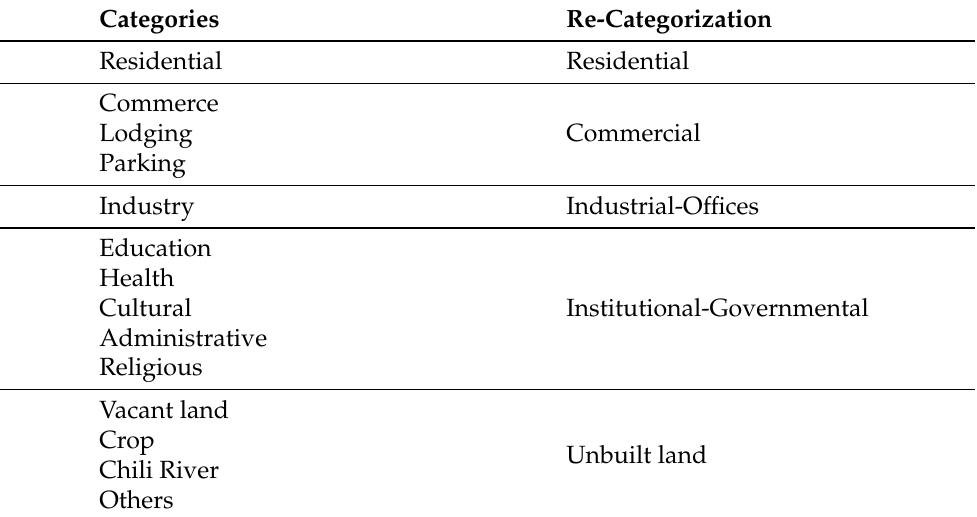
Table 1. Re-categorization of land use categories